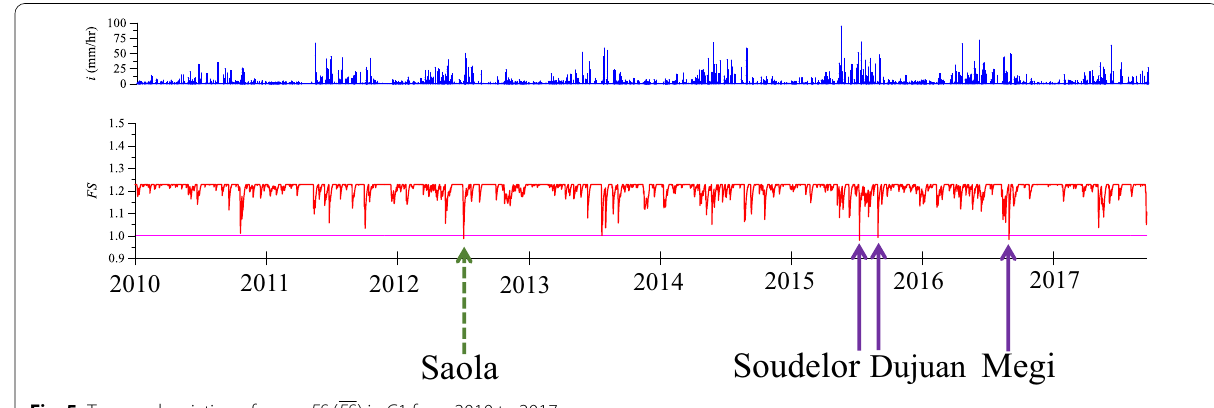
Fig. 5 Temporal variation of mean FS ( FS ) in C1 from 2010 to 2017